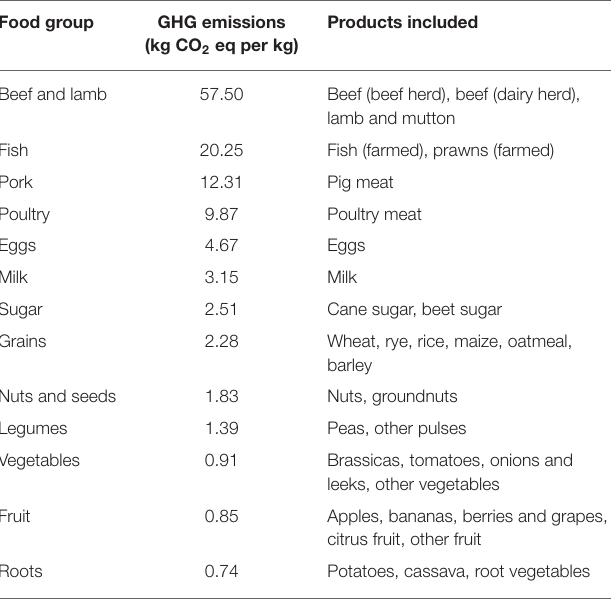
TABLE 2 | GHG emissions associated with major food